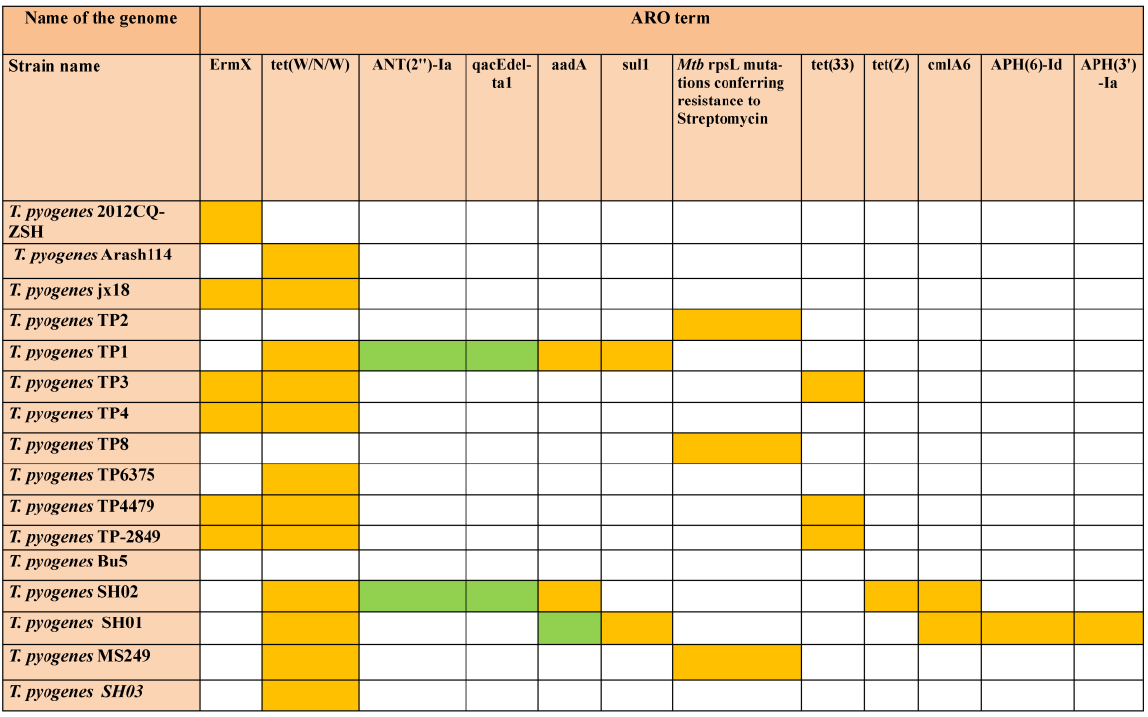
Figure 10. Antimicrobial resistance genes (ARGs) detected in the investigated T. pyogenes strains by the CARD database. The yellow and green boxes in the table depict ARGs classified into perfect and strict categories, respectively, by the RGI software of CARD database.